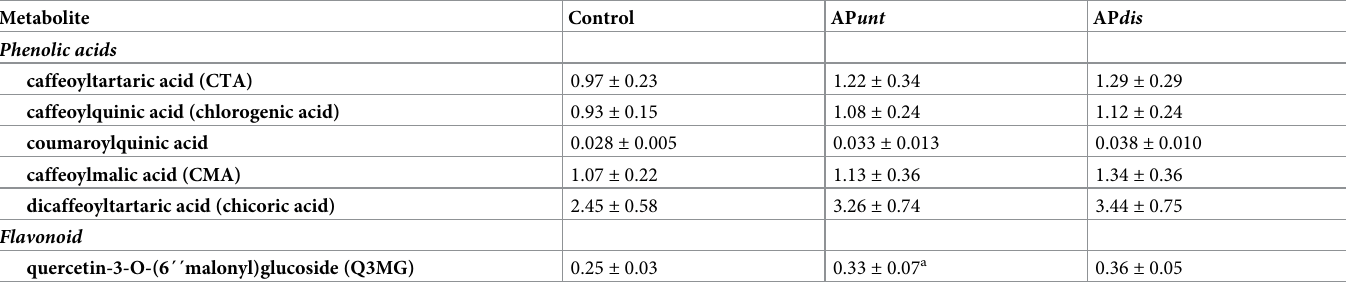
Table 7. Concentrations of phenolic acids and flavonoid glycosides in mg per 100 g fresh weight in butterhead lettuce caused by different nutrient solutions. The nutrient solutions for control were prepared with fresh and rain water (50:50, v/v) and for AP unt and AP dis with fish water. The latter were untreated for AP unt and disin- fected for APdis. The data represent mean values of four lettuce heads samples, mixed in turn of three different lettuce heads ± standard deviation. No significant differ- ences (p < 0.05) were analysed using univariate ANOVA and Tukey-HSD test (caffeoyltartaric acid, caffeoylquinic acid, and caffeoylmalic acid) or using Kruskal-Wallis test.